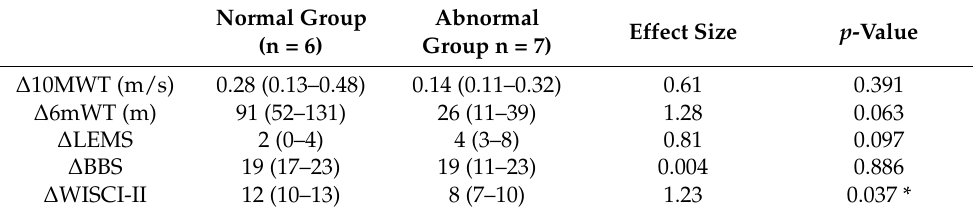
Table 4. Comparison of clinical outcomes by initial proprioception status.